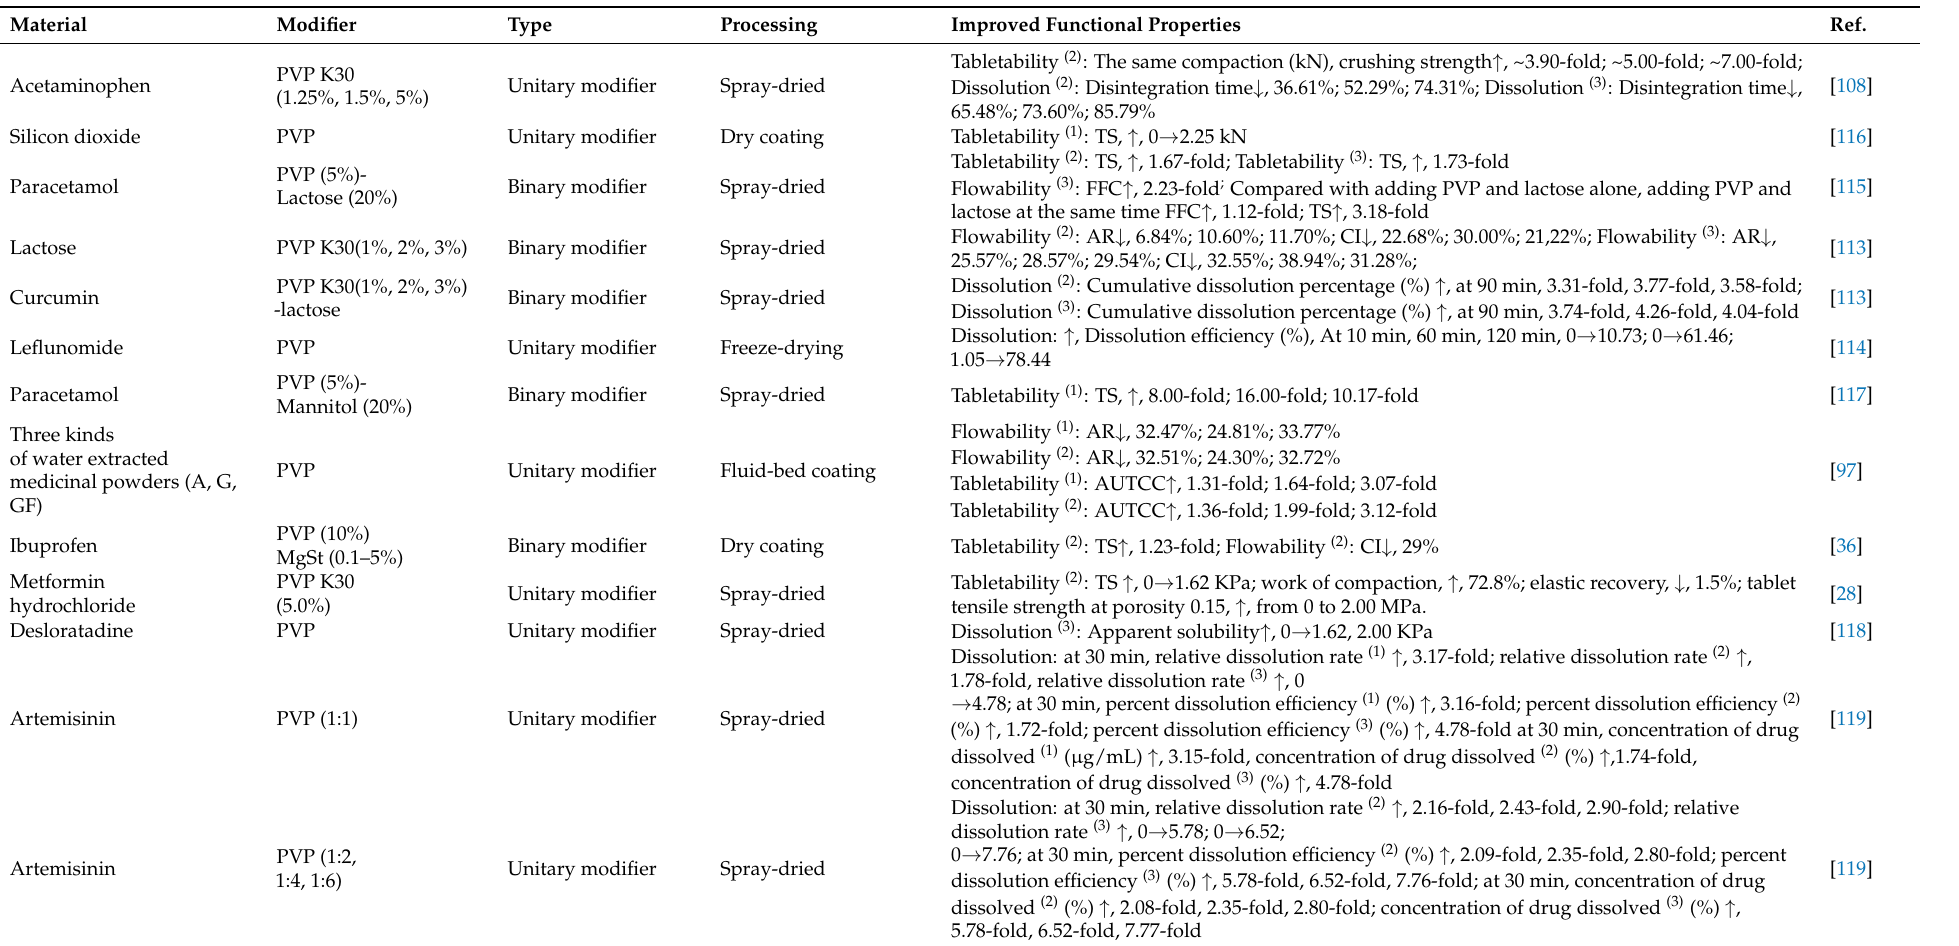
Table 2. The application of